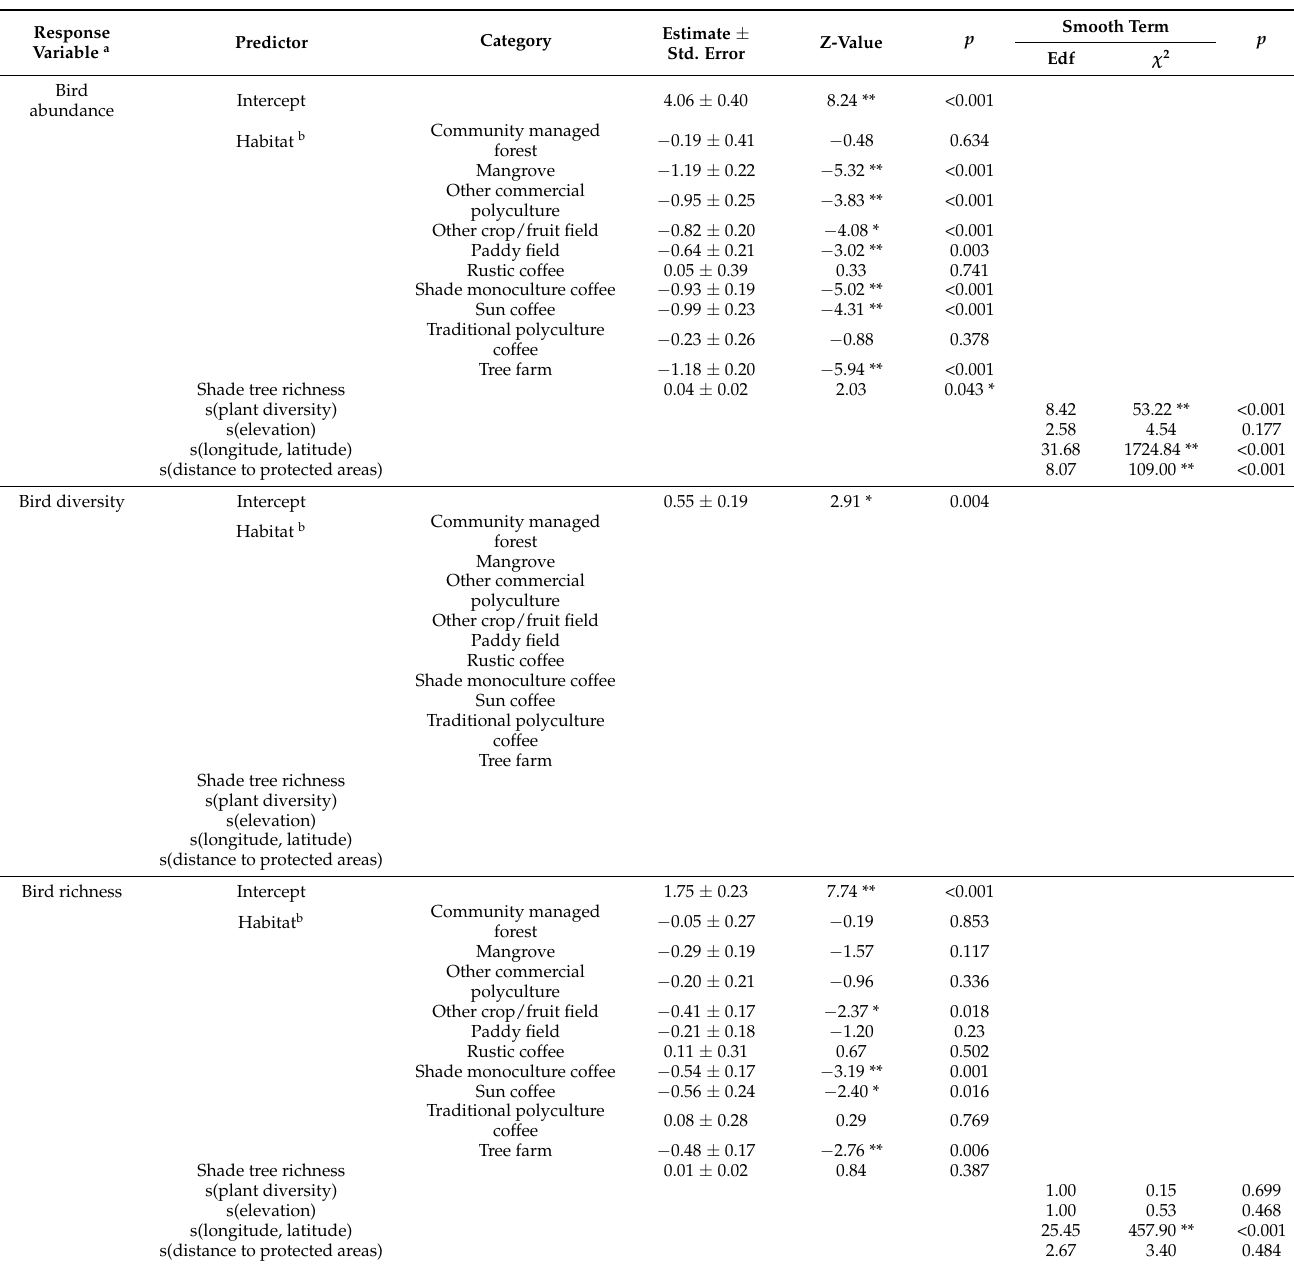
Table 2. Results of generalised additive models to understand the influence of habitat type and other environmental predictors on the abundance, diversity, and richness of birds in 21 sites, 1226 plots, in Java,